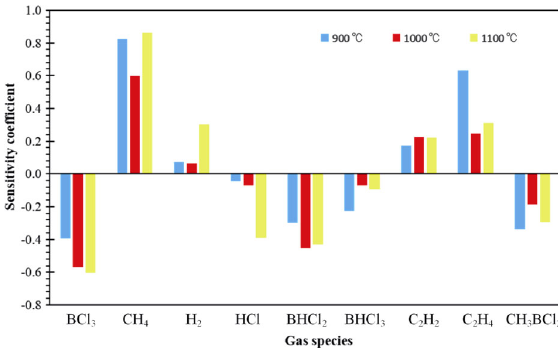
Fig. 11 Analysis of the sensitivity of the intermediate species with respect to the B/C under different temperatures by ML.